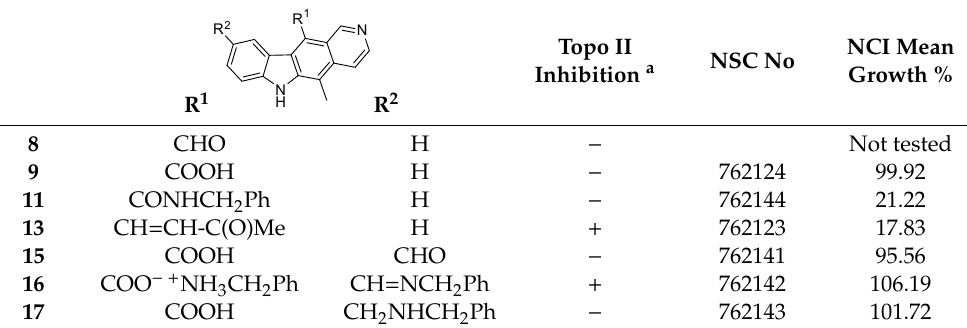
Figure 3. Screen of topoisomerase II inhibitory activity of the ellipticine derivatives at 100 µM. Table 1. 11-Substituted ellipticine topoisomerase activity and National Cancer Institute (NCI) mean growth percent (single dose). NR 1 R 2 N H